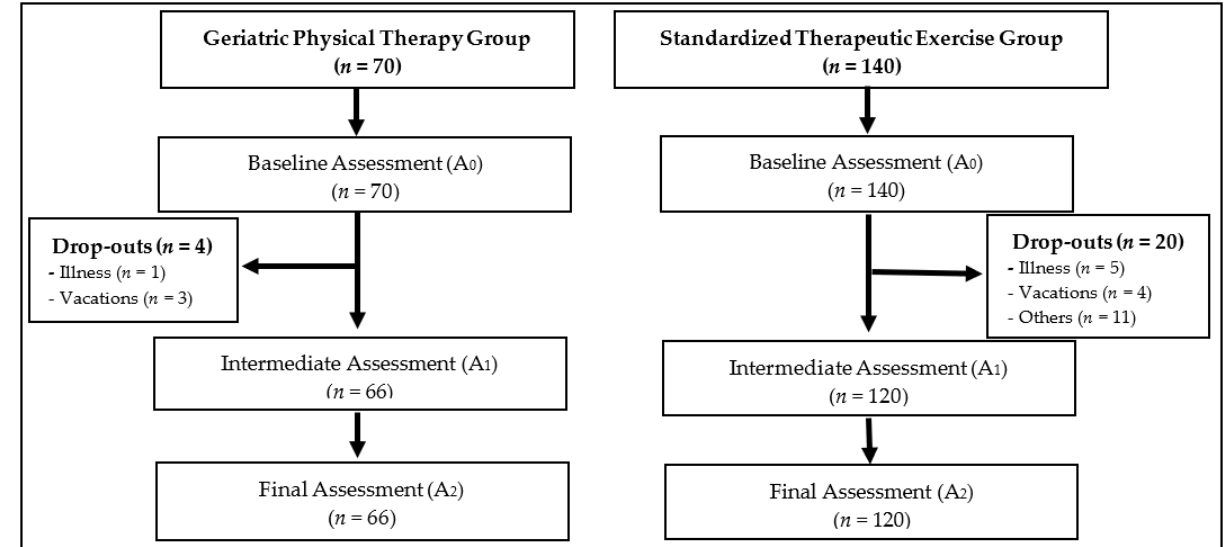
Figure 1. Participant flow according to the intervention groups.